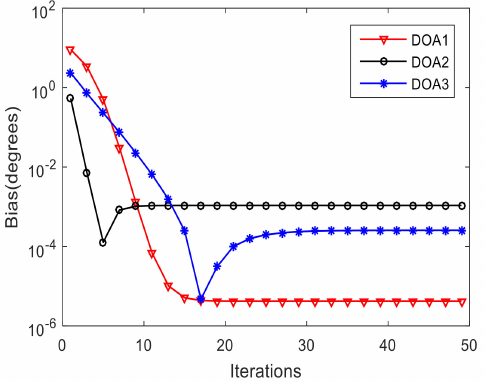
Figure 5. Variation of the estimated DOAs versus the iteration times.